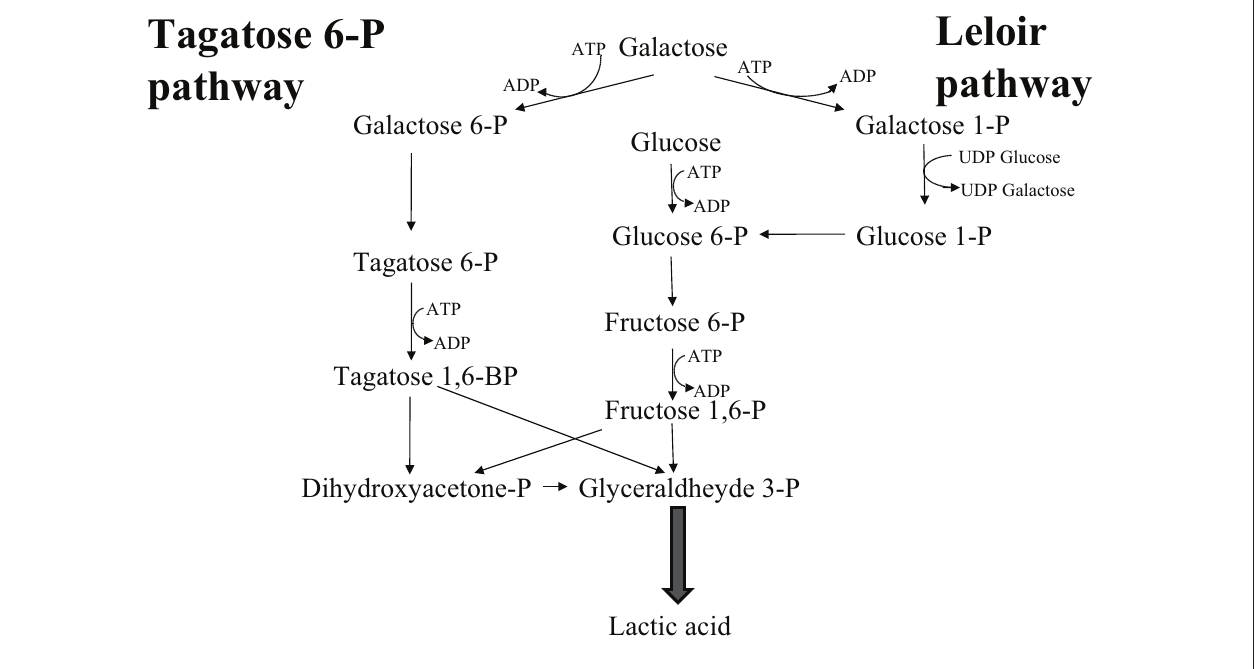
FIGURE 1 | Galactose metabolism in Lactic Acid